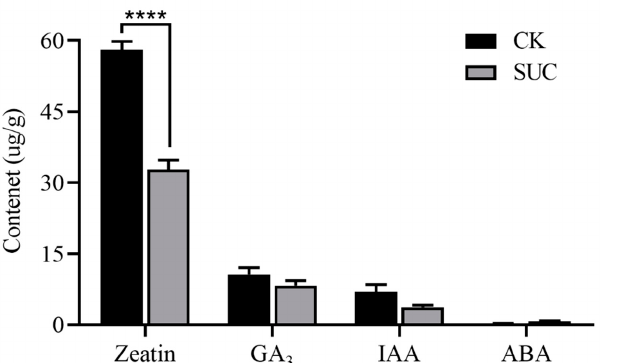
Figure 2. Effects of sucrose treatment on the contents of zeatin, GA 3 , IAA, and ABA in endosperm of P. ostii. The black bar represents the control group, while the grey bar represents sucrose-treated group. Each value represents the mean ± SD of three replicates ( n = 3). Asterisks indicate significant differences between the sucrose treatment group and the controls: **** p < 0.0001 ( t